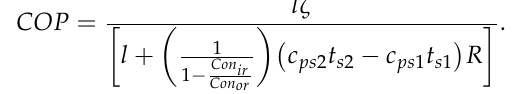
Figure 13. Wood after